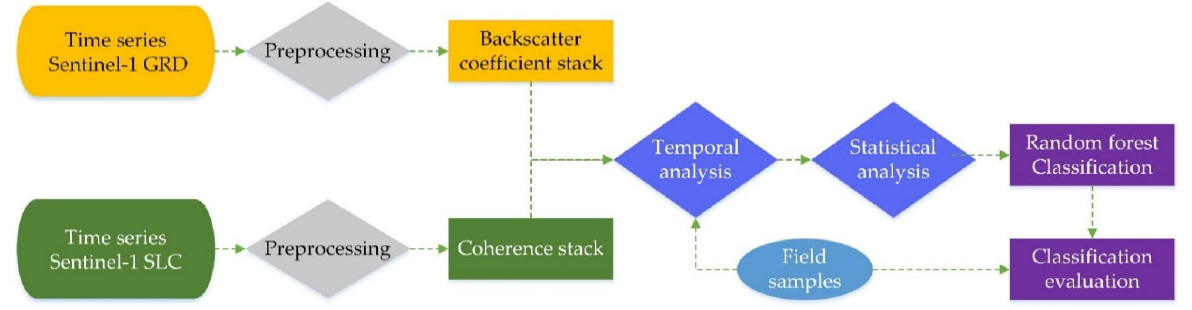
Figure 4. Methodological flowchart of this study.